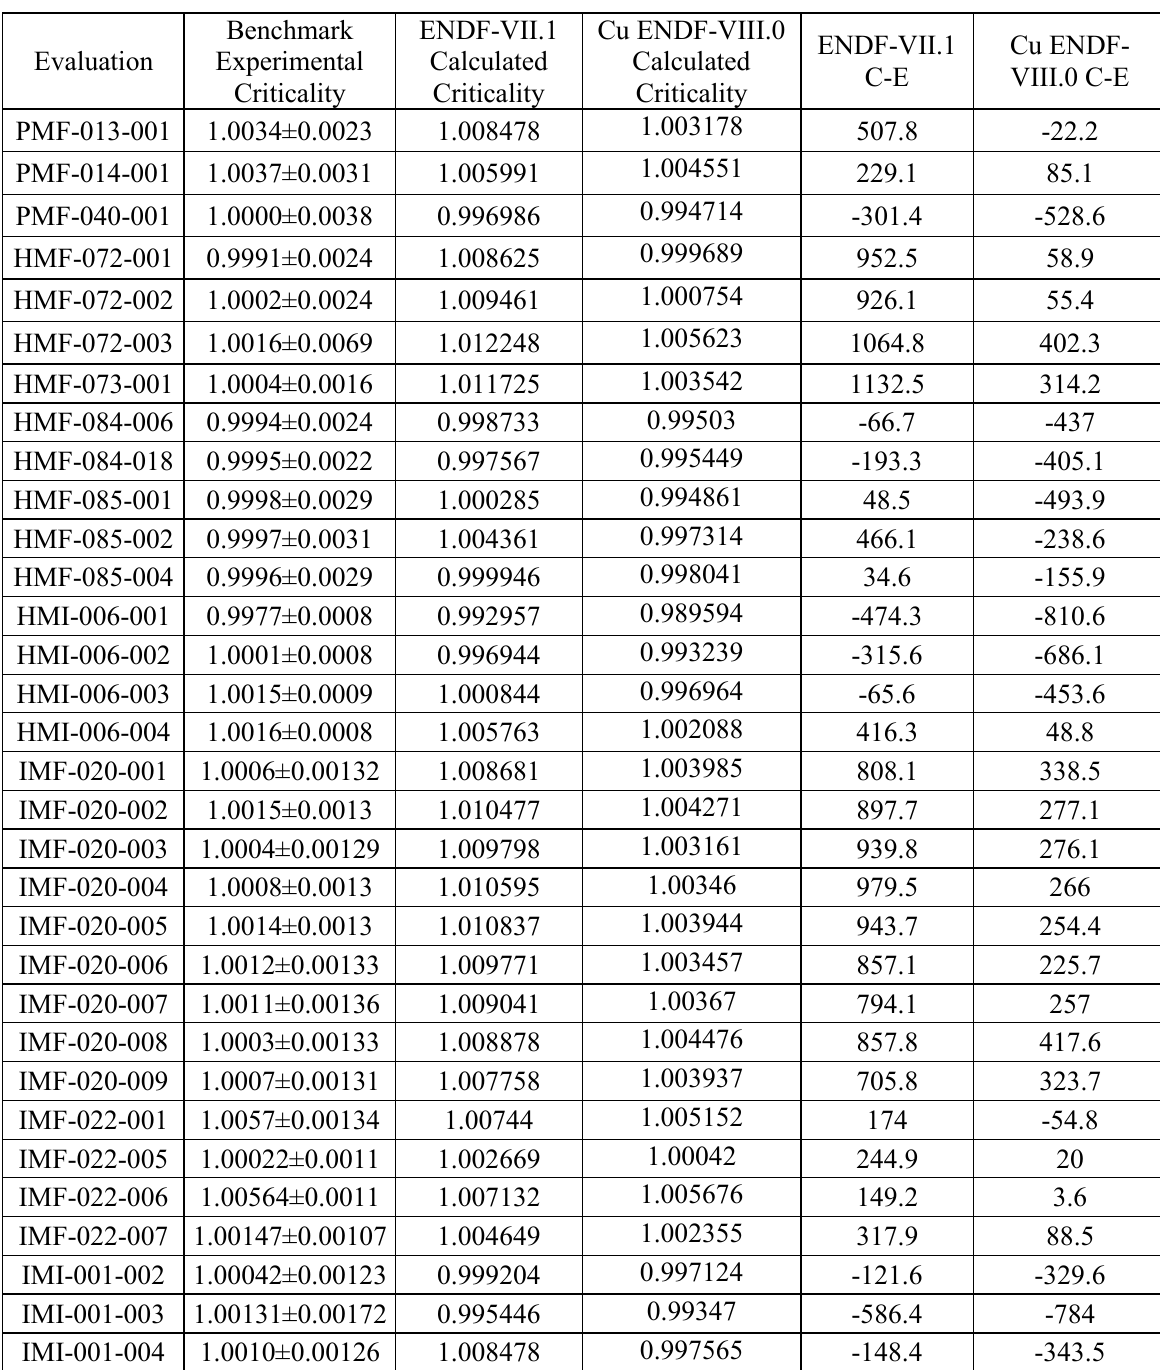
Table III. Cu ENDF-VIII.0 Replacement: Evaluations listed with their SCALE calculated criticality and deviation from experimental benchmarked criticality, in ENDF-VII.1 and with Copper ENDF-VIII.0 Cross